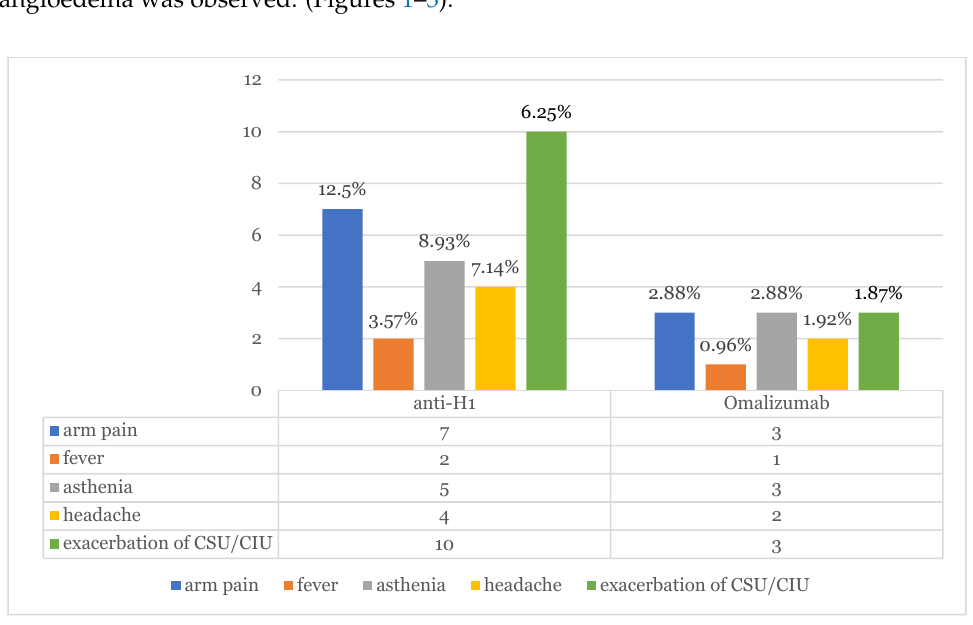
Figure 2. Exacerbation of CSU/CIU symptoms in the subgroup of patients who were taking omalizumab.